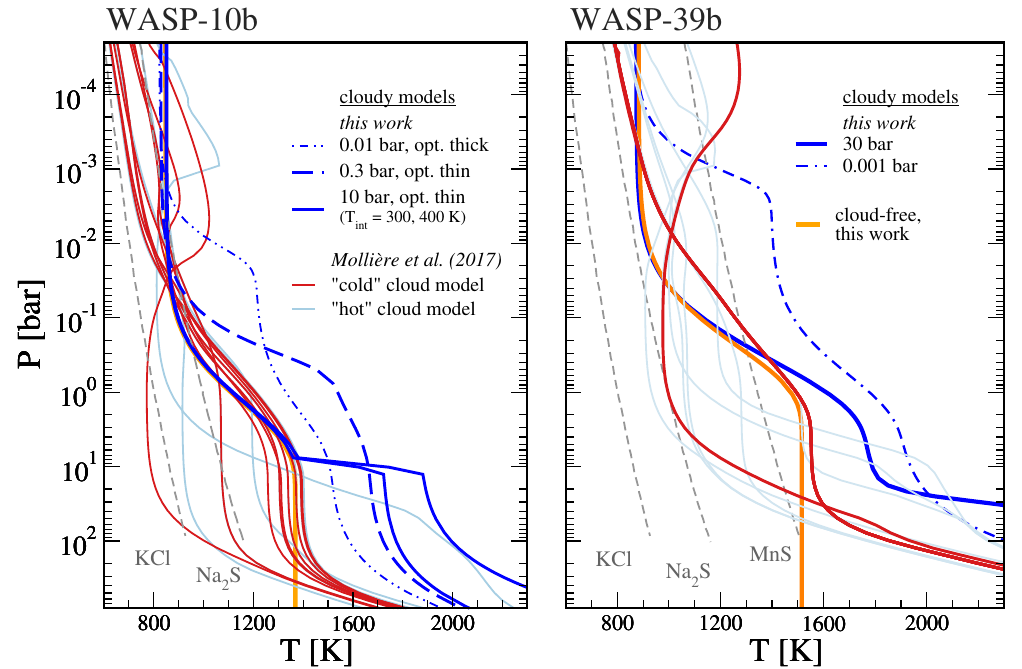
Figure 11. Atmospheric temperature structures for WASP-10b (left) and WASP-39b (right). Our result for the clear atmosphere is shown in orange for T int = 0 K as well some of our cloudy solutions in dark blue. The bunch of profiles in red ( cold models ) and light blue ( hot models ) are from Mollière et al. (2017) for different cloud model parameter, see text. The condensation curves assume solar elemental